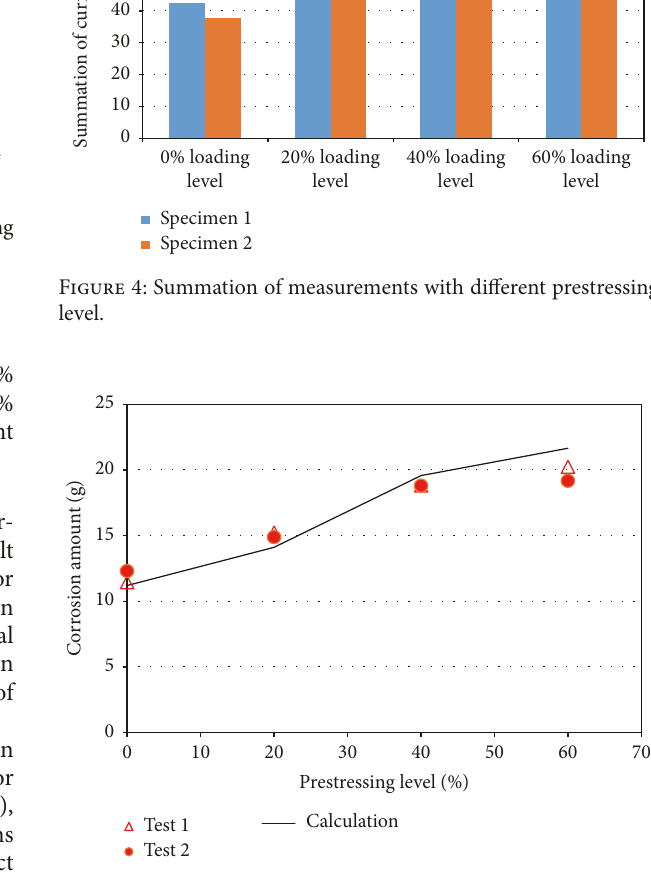
Figure 5: Corrosion amount with stress